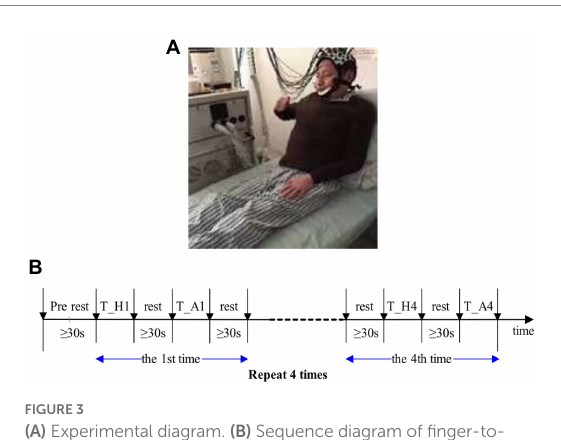
FIGURE 3 (A) Experimental diagram. (B) Sequence diagram of finger-to- nose test. T_H, motor task of the healthy side of the upper limb; T_A, motor task of the upper limb. Patients with muscle strength level below 3 were unable to complete the tasks so they should focus on completing the finger and nose test in motor